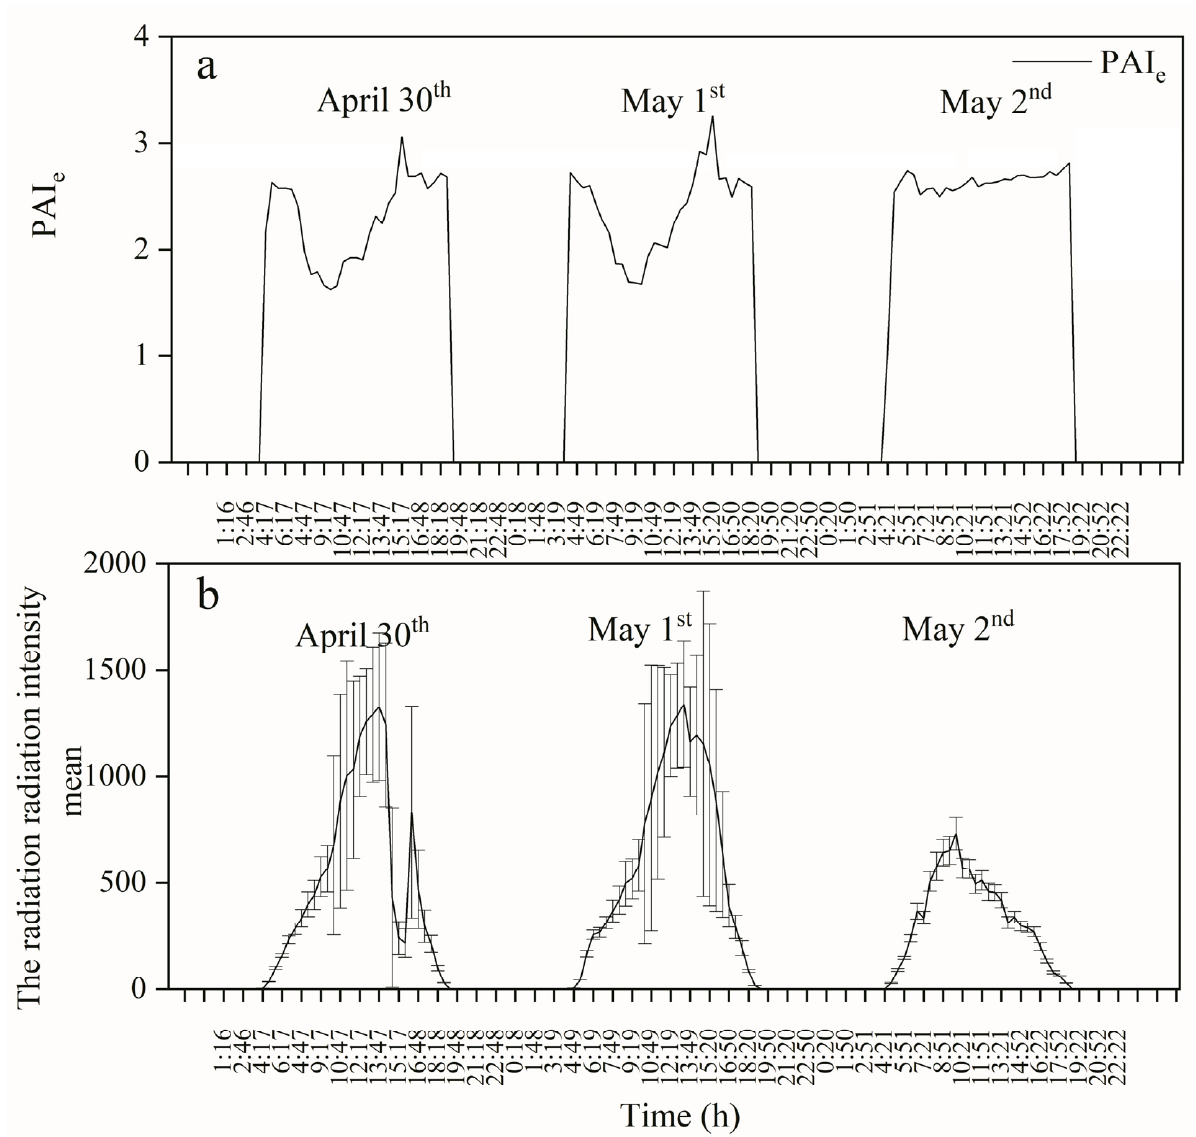
Figure 4. PAI e data observed every 30 min for 3 days ( a ). Mean value of the standard deviations from seven zenith angles ( b ). The data for the above-canopy values were chosen for further analysis. The standard deviations of seven azimuth radiation intensities from the same zenith angle and the same batch were calculated. The mean value of the standard deviations from the seven zenith angles and the mean value of all 49 radiation intensities were calculated and are shown in Figure 4b. This figure shows that the mean intensity reached a peak at noon and that the standard deviations of 30 April and 1 May (both sunny days) were substantially higher than that of the cloudy day. These conclusions could guide the choice of transmittance values for accurate calculations of PAI e in subsequent